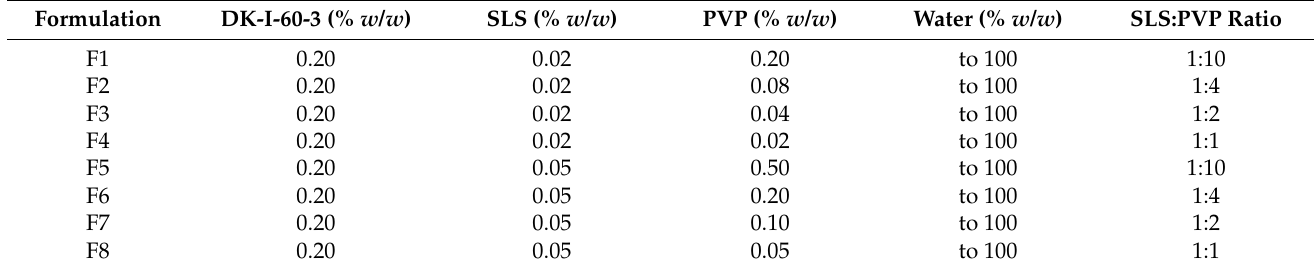
Table 1. Composition of developed nanocrystal dispersions.